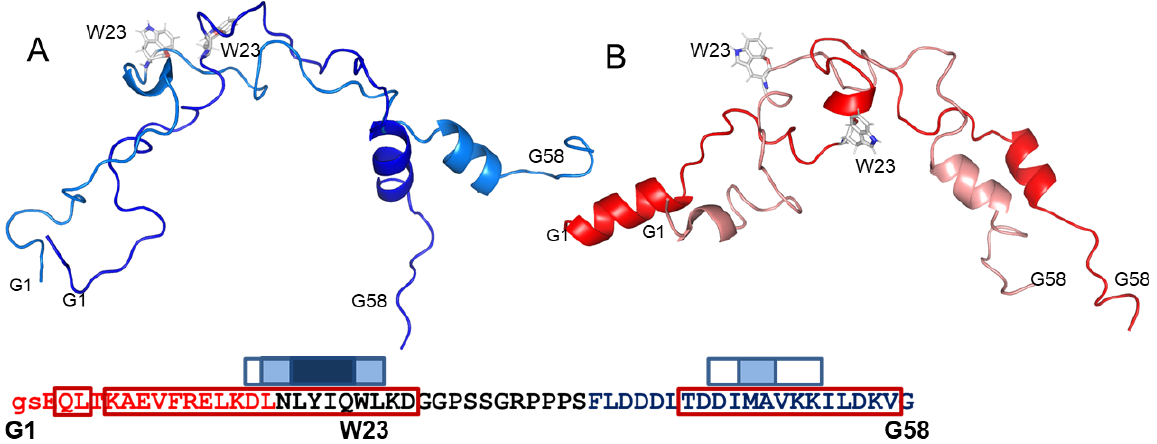
Figure 7. Centroid representations of two A-Cage-C clusters in the absence (blue shades) and presence (red shades) of bicelles at pH 4.5. ( A ) Centroid representation of Cluster 1 (Dark Blue; 6349 structures) and Cluster 2 (Light Blue, 3651 structures) of the Flexible-Meccano analysis. The input of NMR data accumulated at pH 4.5 in the absence of bicelles were used. ( B ) Centroid representation of Cluster 1 (Dark Red, 5105 structures) and Cluster 2 (Light Red, 4891 structures) of the Flexible-Meccano analysis. The input of NMR data accumulated at pH 4.5 in the presence of bicelles were used. For both panels, all structures were loaded in PyMOL, aligned to Cluster 1 of Panel A, and represented as backbone cartoons. The termini residues, G1 and G58, as well as and the Cage Tryptophan, W23, are indicated. Bottom inset: A-Cage-C Sequence information aligned with horizontal axis residue number. Red, black, and blue capital letters indicate Helix A, Trp-Cage, and Helix C motifs; lower case letters indicate two remaining residues from TEV cleavage; Red frames indicate predicted helices; White, light blue and dark blue boxes indicate increasing AMYLPRED2 consensus. For further details, see Figure 2 and Materials and Methods.